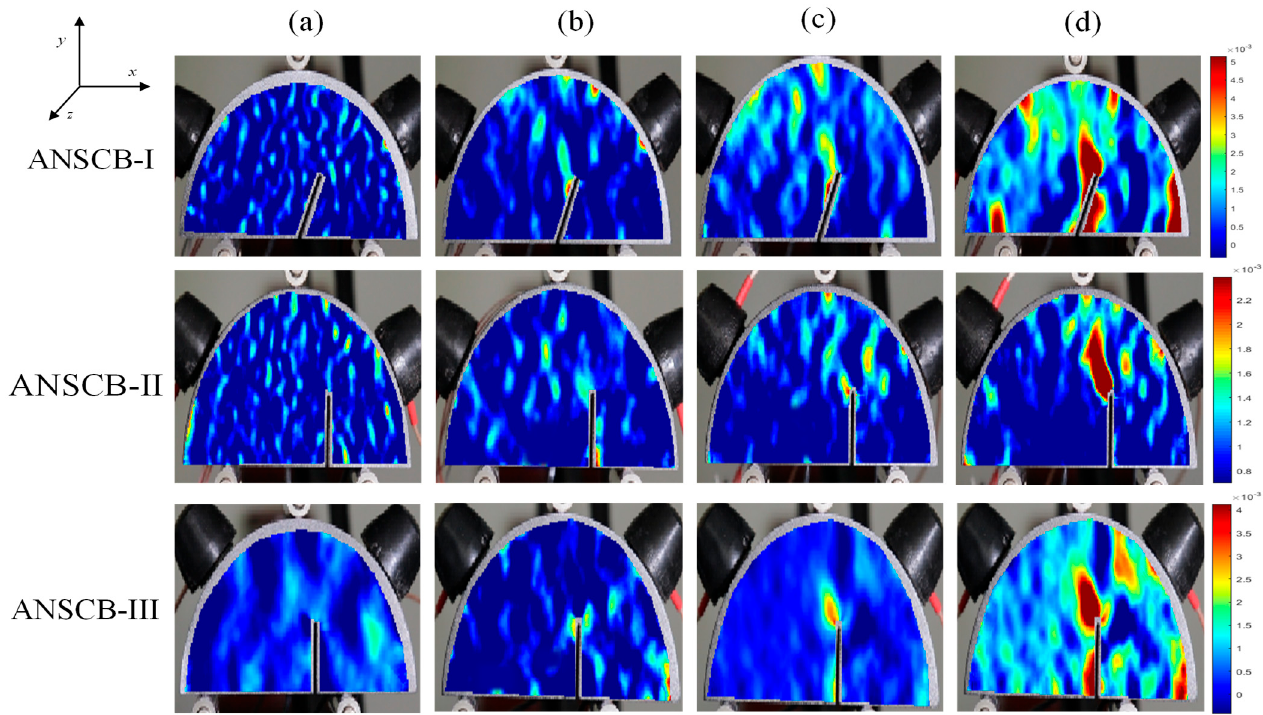
Figure 6. Evolution of strain ε xx representing different cracking stages: ( a ) Nonlinear elastic stage; ( b ) fracture process zone; ( c ) crack initiation stage; ( d ) crack propagation stage.